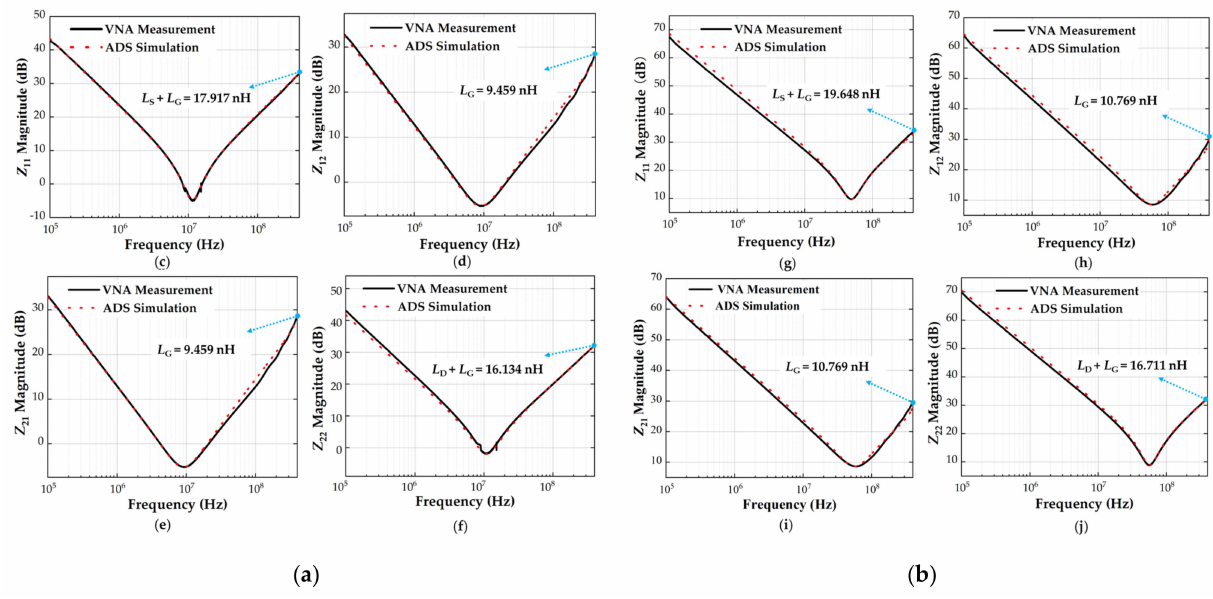
Figure 8. Z − parameters obtained from experimental measurement and ADS simulation. ( a ) Si MOSFET IXFK32N100P in TO − 247 package (( c ) Z 11 , ( d ) Z 12 , ( e ) Z 21 , ( f ) Z 22 ). ( b ) SiC MOSFET C2M0160120D in TO − 247 package (( g ) Z 11 , ( h ) Z 12 , ( i ) Z 21 , ( j ) Z 22 ).